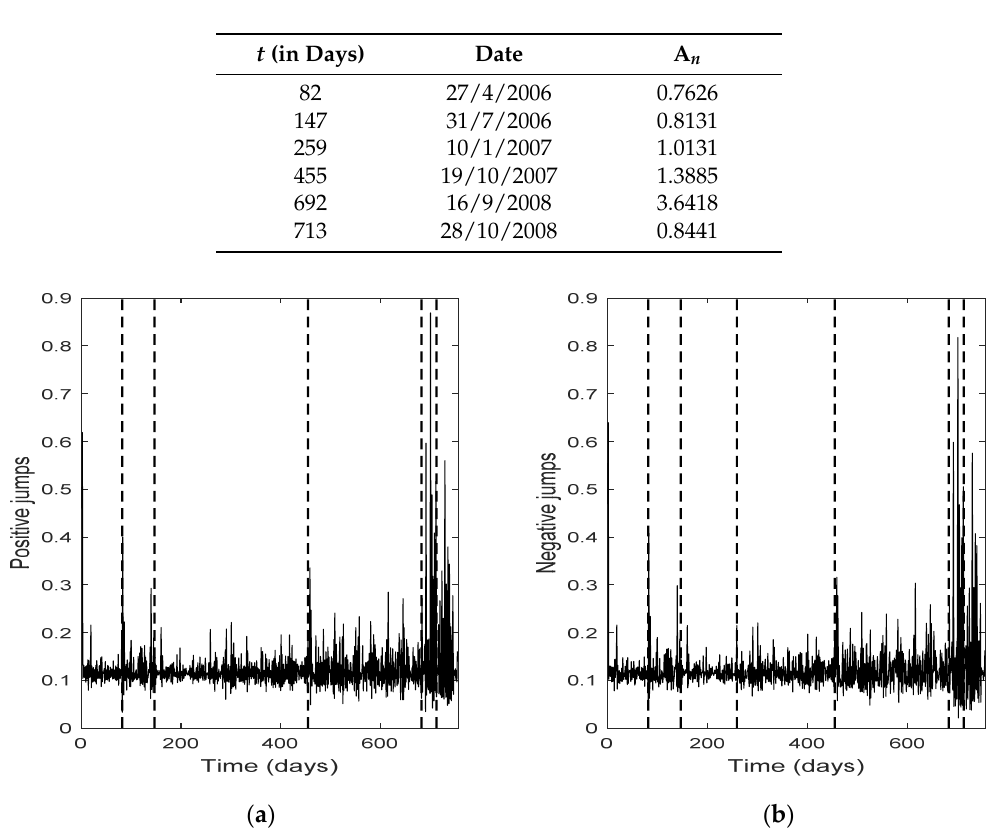
Figure 8. ( a ) Change points for the estimated positive jumps of Microsoft; ( b ) Change points for the estimated negative jumps of Microsoft. estimated negative jumps of